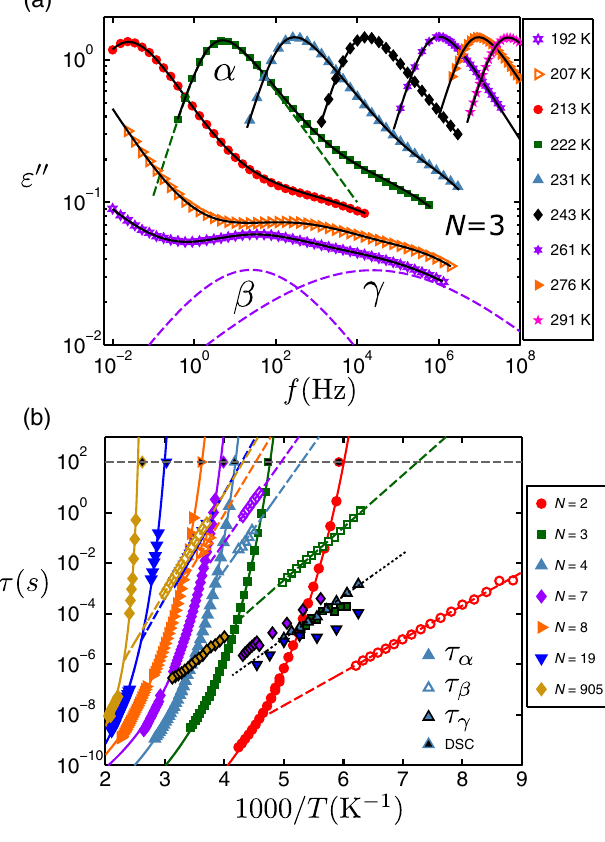
FIG. 1. (a) Dielectric loss ε 00 ð f Þ for PMMA with N ¼ 3 at different T . Dashed lines show α , β , and γ relaxations, while solid lines are fits to the spectra, as described in Appendix A. (b) Arrhenius plot showing the characteristic relaxation peak timescales: τ α (filled symbols), τ β (open symbols), and τ γ (filled symbols, black outline) for PMMA with N ∈ 2 – 905 . The solid lines are VFT fits to the τ α data, the dashed lines are Arrhenius fits to τ β ð T Þ , and the dotted line is an Arrhenius fit to τ γ ð T Þ for N ¼ 4 (fits to other N are omitted for clarity). All fitting parameters are tabulated in Table VII. DSC data are shown as black-filled symbols at τ ¼ 10 2 s (horizontal dashed line), which defines T